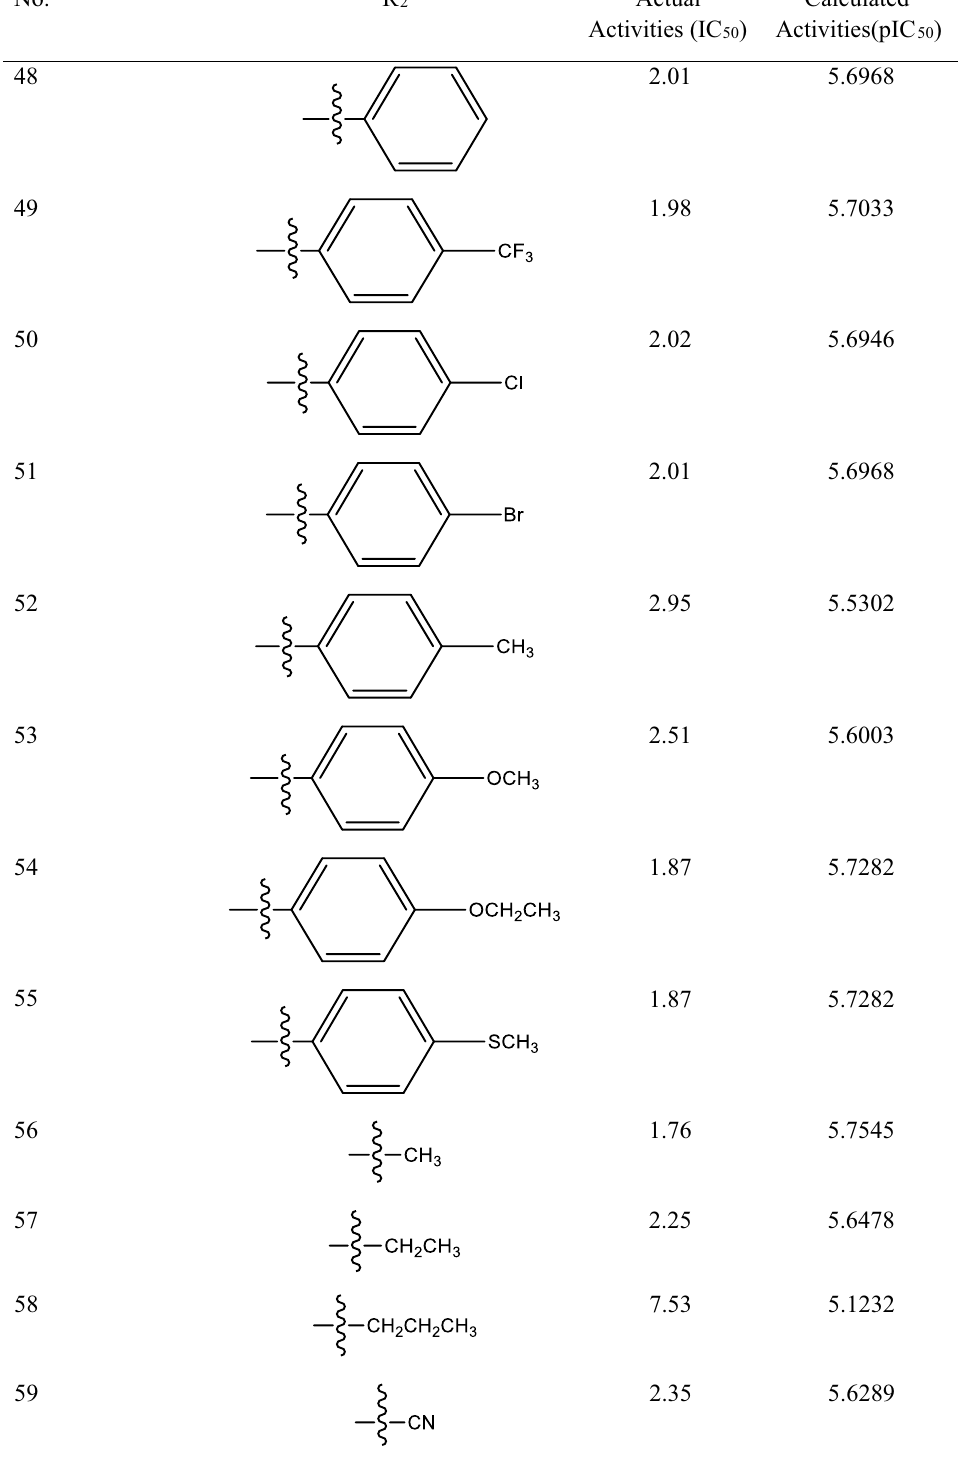
Table 4 The inhibitory activity of parthenolide derivatives for template molecule 4